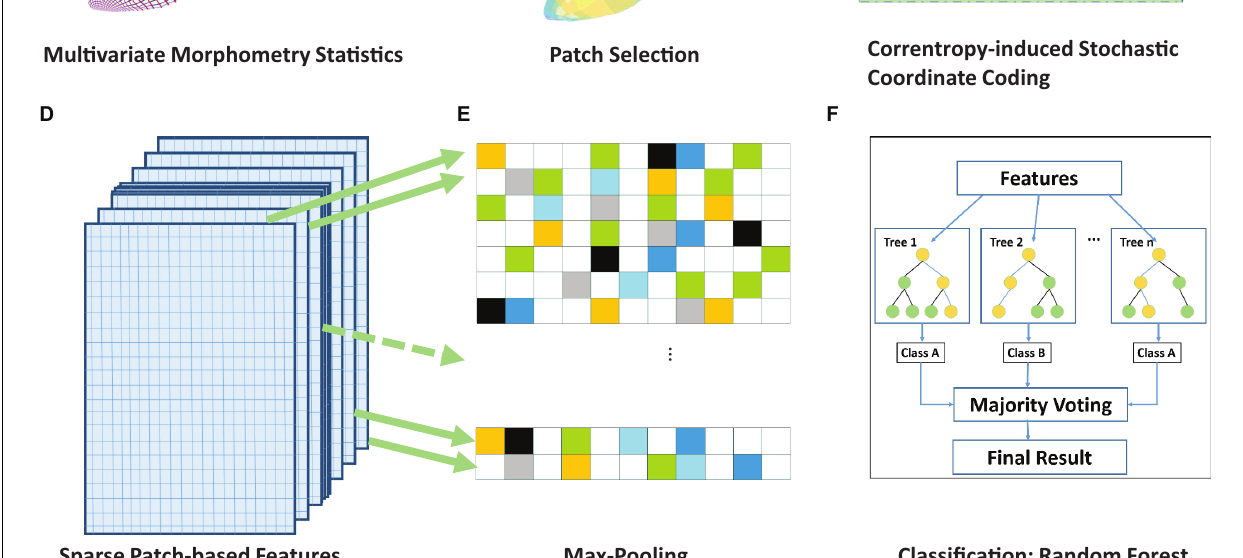
Frontiers in Neuroscience |